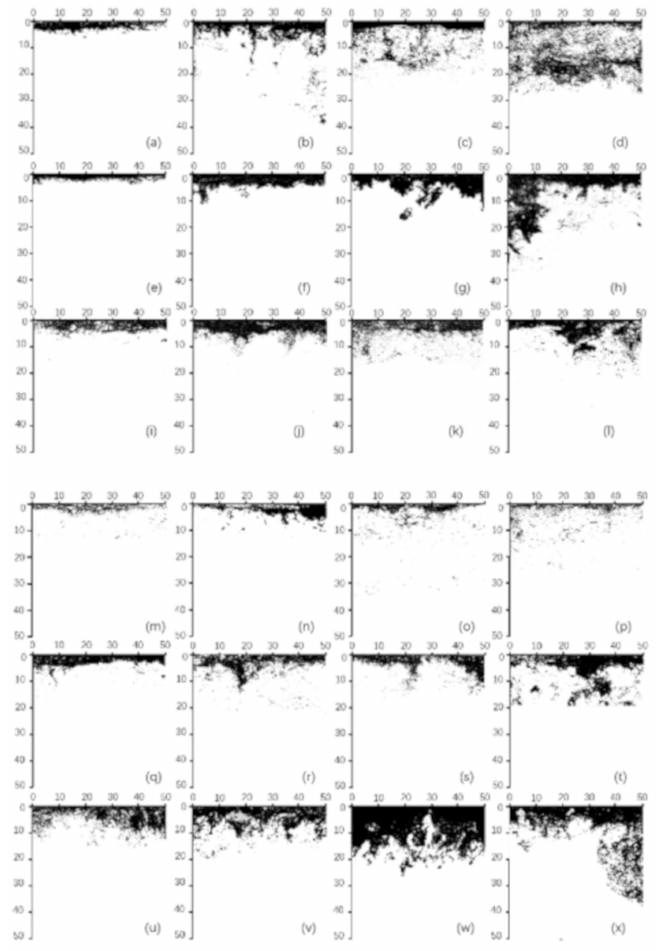
Figure 2. Example dyeing images for vertical soil sections in the three types of sites under di ff erent precipitation amounts. ( a – d ) correspond to the vertical sections of Pinus yunnanensis Franch. var. tenuifolia plantation forestland at G5, G15, G35 and G55, respectively; ( e – h ) refer to the vertical sections of secondary forestlands at G5, G15, G35 and G55, respectively; ( i – l ) correspond to the vertical sections of Eucalyptus robusta Smith plantation forestland at G5, G15, G35 and G55, respectively; ( m – p ) correspond to the vertical sections of Platycladus orientalis ( L .) Francoptmxjjkmsc cypress plantation forestland at G5, G15, G35 and G55, respectively; ( q – t ) correspond to the vertical sections of scrubland at G5, G15, G35 and G55, respectively; ( u – x ) correspond to the vertical sections of grassland at G5, G15, G35 and G55, respectively. G5, G15, G35 and G55 correspond to 5, 15, 35, and 55 mm ponded water infiltration simulations, which simulate the change in ponded water in light rain, medium rain, heavy rain, and storm,